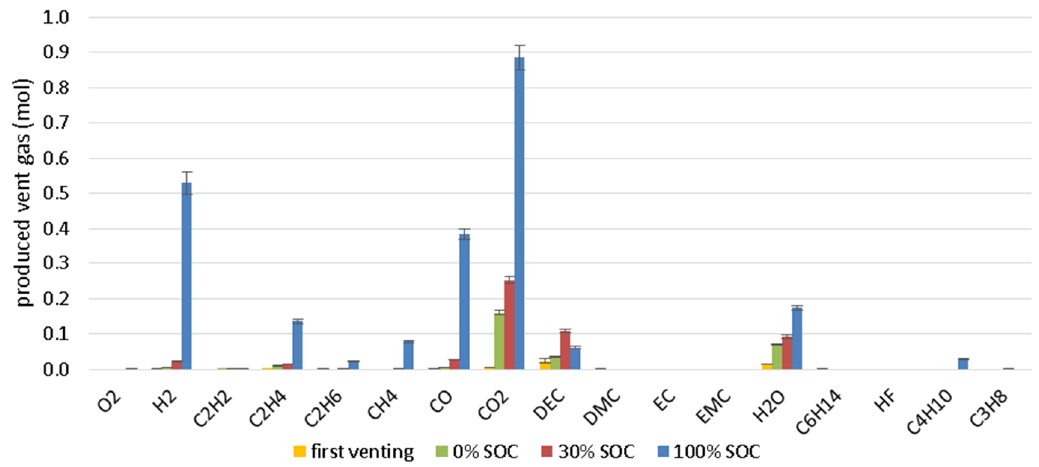
Figure 10. Measured gas composition in mol: immediately after the first venting at T V 1 of the 100% SOC cell (yellow); after the heat ramp was stopped at the 0% (green) and 30% SOC cell (red); and after the TR of the 100% SOC cell (blue); experimental setup in N 2 .